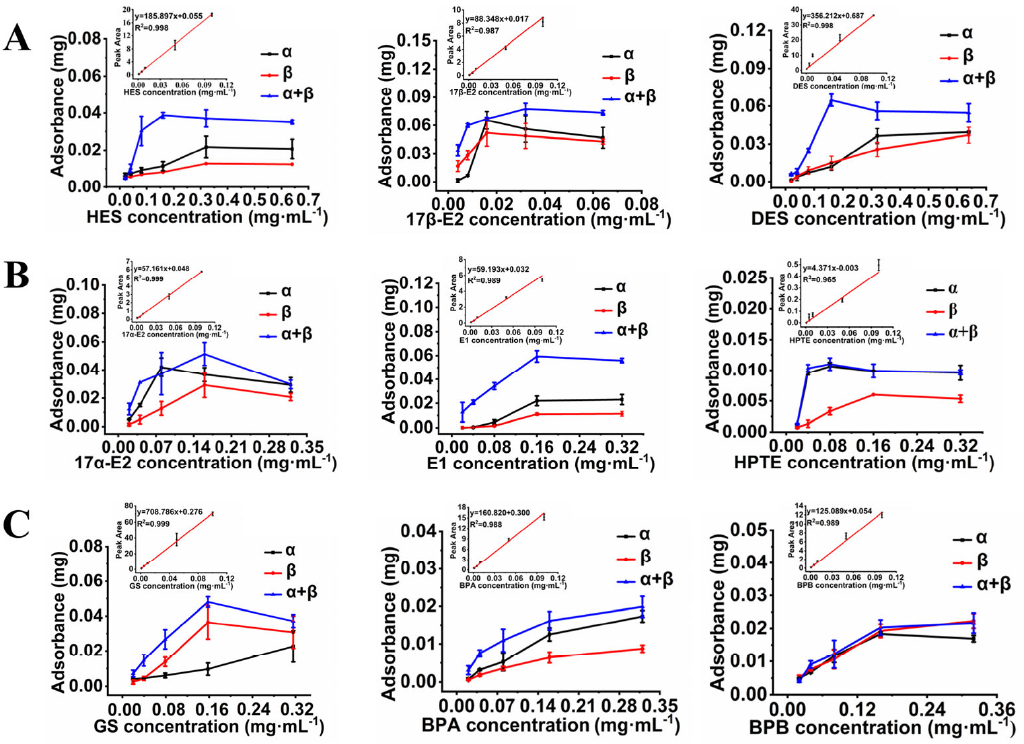
Figure 1. Adsorption capacity of SPE columns prepared with ER α , ER β , and ER cocktail for EDC adsorption. ( A ) The adsorption capacity of DES, 17 β -E2, and HES with high estrogenic activities. ( B ) The adsorption capacity of 17 α -E2, E1, and HPTE with moderate estrogenic activities. ( C ) The adsorption capacity of BPA, BPB, and GS with low estrogenic activities. Inset: standard curves of nine EDCs determined by HPLC.